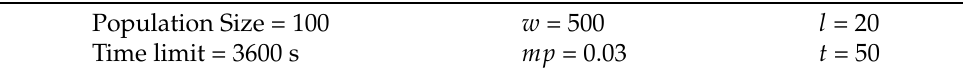
Table 1. Parameters used by the proposed algorithms. Population size, mutation probability ( mp ), number of incompatibilities introduced on the original instance ( l ), window width ( w ), maximum number of transitions ( t ), and time limit are given.